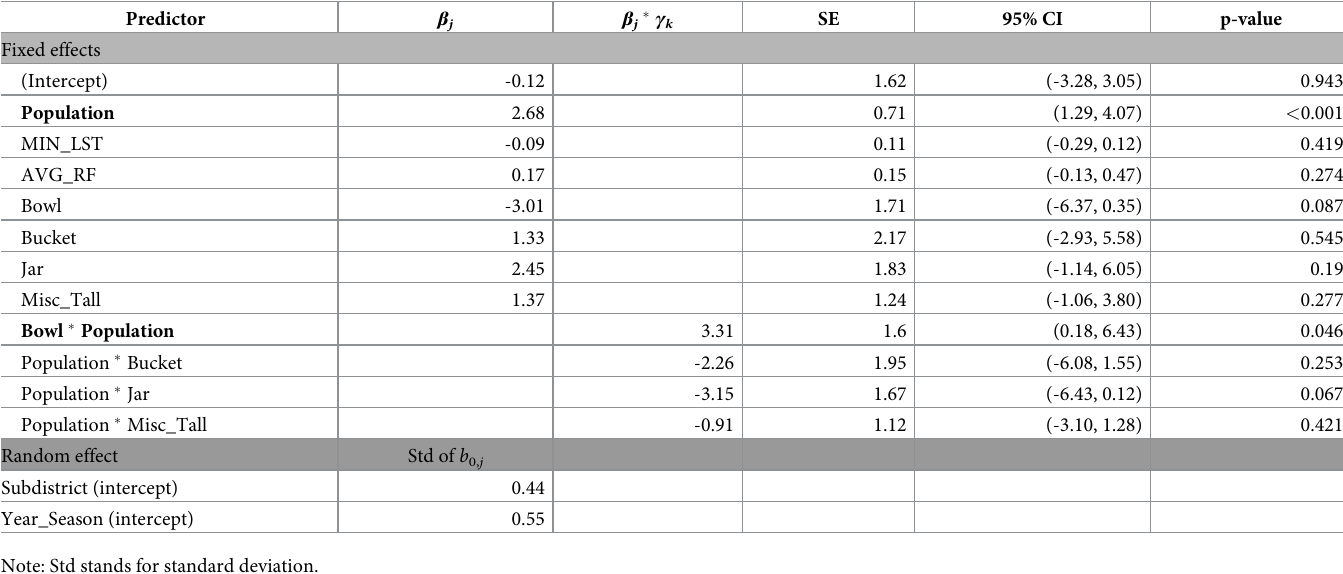
Table 7. The coefficients of the LMER+C models using training data (2015–2017) for Krabi province. Significant variables with a p-value < 0.05 are indicated with boldface.